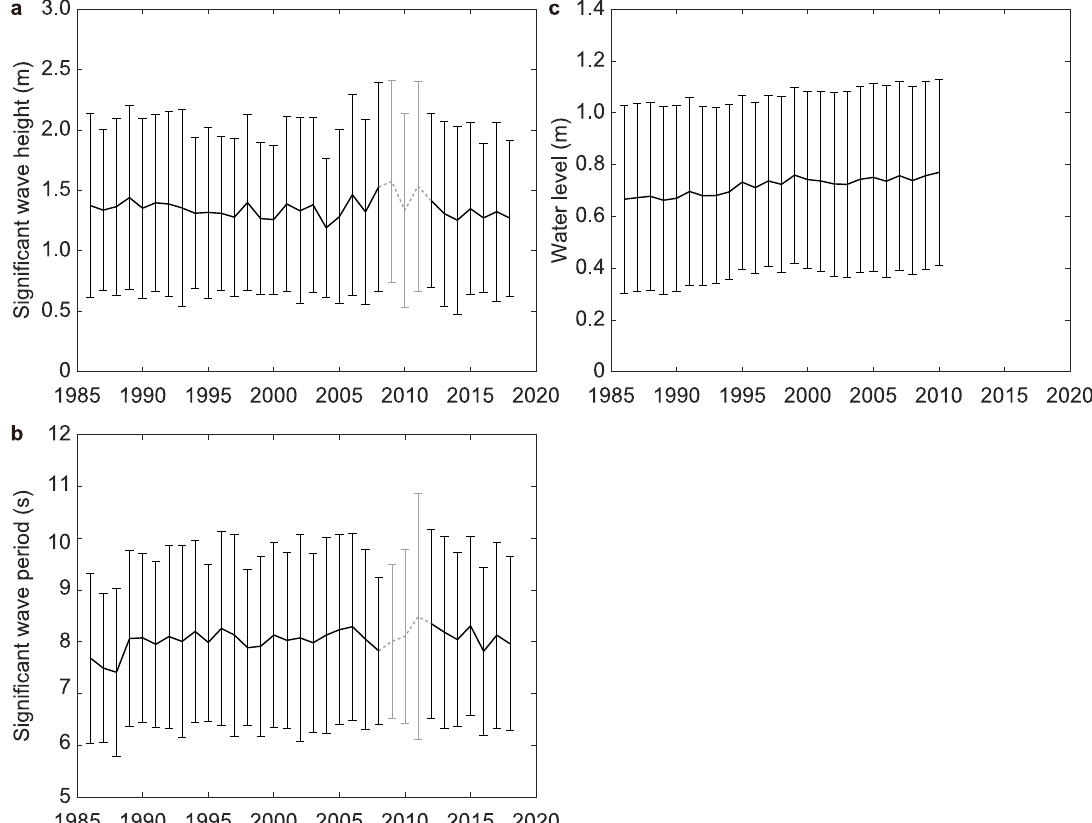
Figure 7. Annual mean of deepwater significant wave height and period and water level with ±1 S.D. ( a ) Significant wave height; ( b ) significant wave period; ( c ) water level.